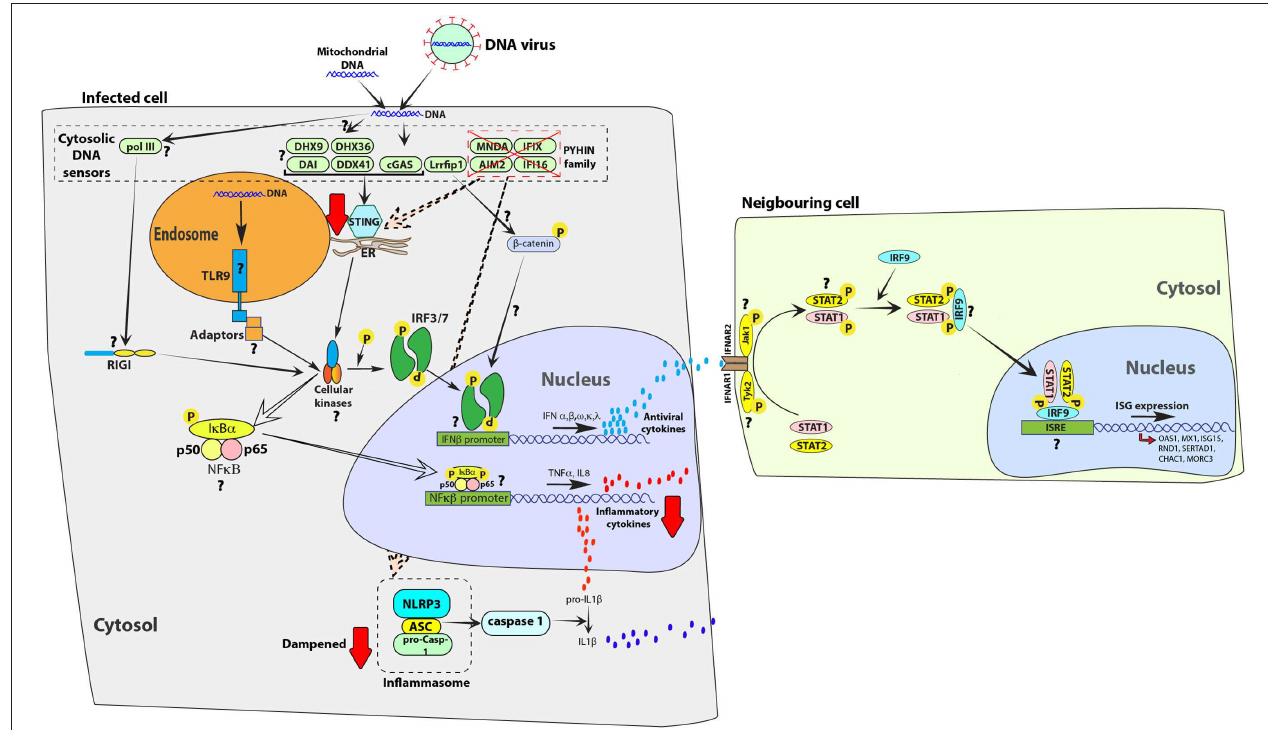
FIGURE 2 | Exogenous and self-DNA sensing pathways are dampened in bat cells. In human cells, endosomal TLR9 (35) and cytosolic receptors from the PYHIN family ( 86) [absent in melanoma 2 (AIM2), IFN-inducible gene 16 (IFI16), myeloid cell nuclear differentiation antigen (MNDA) and IFN-inducible protein X (IFIX)], cyclic GMP-AMP synthase (cGAS) (87), DNA-dependent activator of IFN-regulatory factor (DAI) (88), RNA polymerase III (PolIII) (89), LRR binding FLII interacting protein 1 (Lrrfip1) ( 90), DDX41 (91), DExH-Box helicase 9 (DHX9) and DEAH-Box helicase 36 (DHX36) (92) can detect exogenous and self-DNA (86, 93). On binding to DNA, these receptors signal through adaptor proteins to activate cellular kinases, such as TANK-binding kinase 1 protein (TBK1), which in-turn activates transcription factors, such as interferon regulatory factor 3 (IRF3) or IRF7 and nuclear factor kappa-light-chain-enhancer of activated B cells (NF κ B) to induce expression of antiviral interferons (IFNs) and pro-inflammatory cytokines, respectively. PYHIN family of cytosolic receptors signal through STING and the NLRP3 inflammasome. This family of receptors has been negatively selected for and lost in the genomic sequences of bats (94). A downstream signal mediator of cGAS, stimulator of IFN genes (STING) is less functional in bat cells, relative to human cells ( 95). The attenuated function of STING would likely extend to other DNA sensors that signal through STING, such as DDX41, DHX9, DHX36, and DAI. The presence and function of additional homologs of DNA sensors, such as TLR9, PolIII, and Lrrfip1 have not been characterized in bats. In the figure, red arrows indicate a dampened response in the pathway, relative to human cells. Question marks ( ? ) highlight pathways and molecular homologs that have not yet been characterized or identified in bats. The data have been compiled from studies in different species and one finding may not represent a universal bat response. ER, endoplasmic